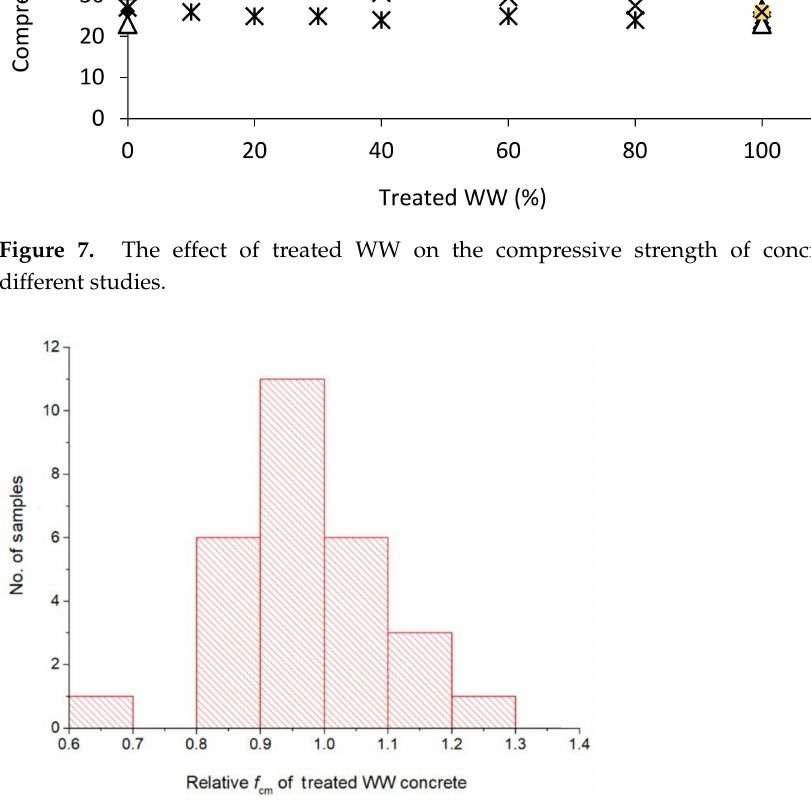
Figure 8. Histogram of relative compressive strength of concrete made with treated WW versus no. of